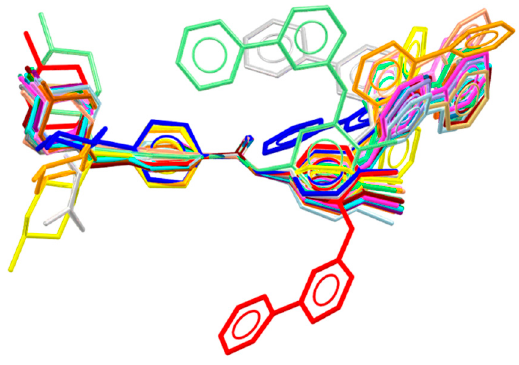
Figure 1. Conformations of imatinib in studied compounds. Four superimposed atoms belong to the amide C Ph C (O)N fragment. Compounds with CSD codes DUNTIQ (red, [30]), XAVTOF